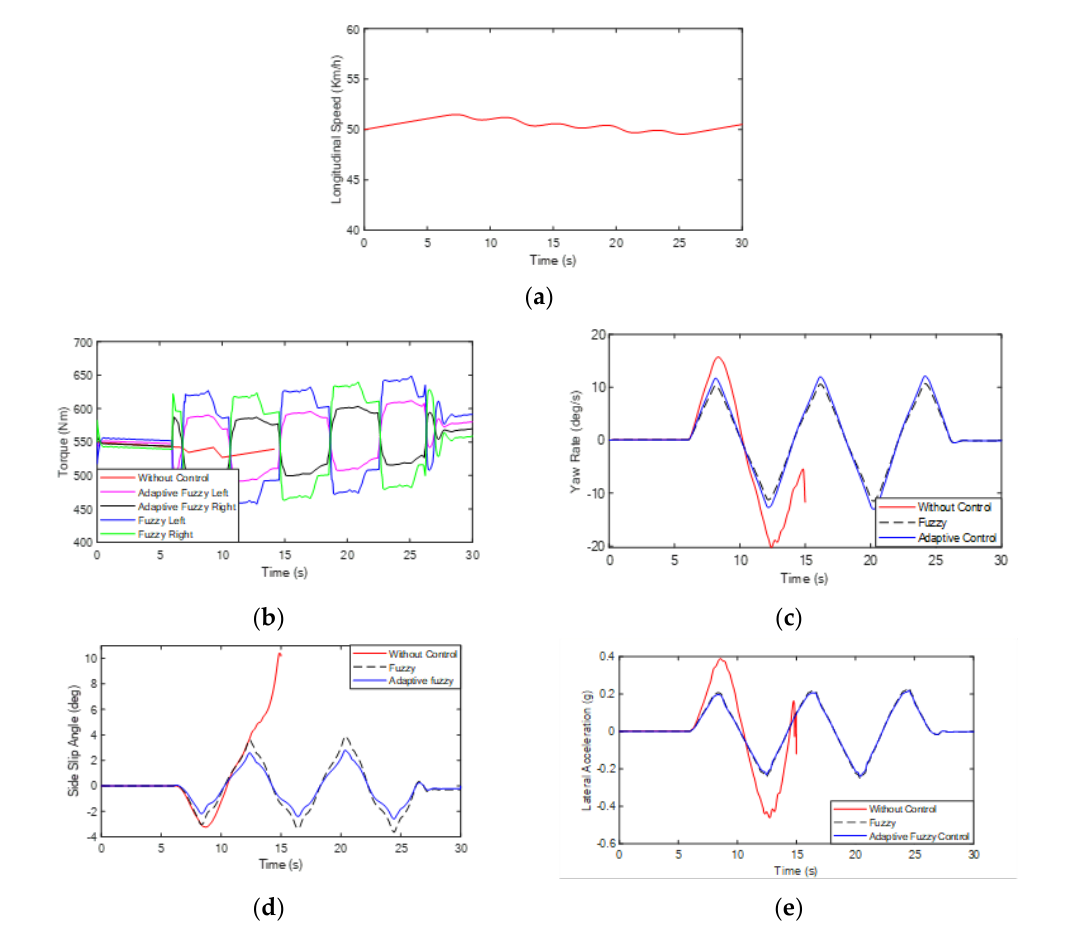
Figure 19. Acceleration pedal.